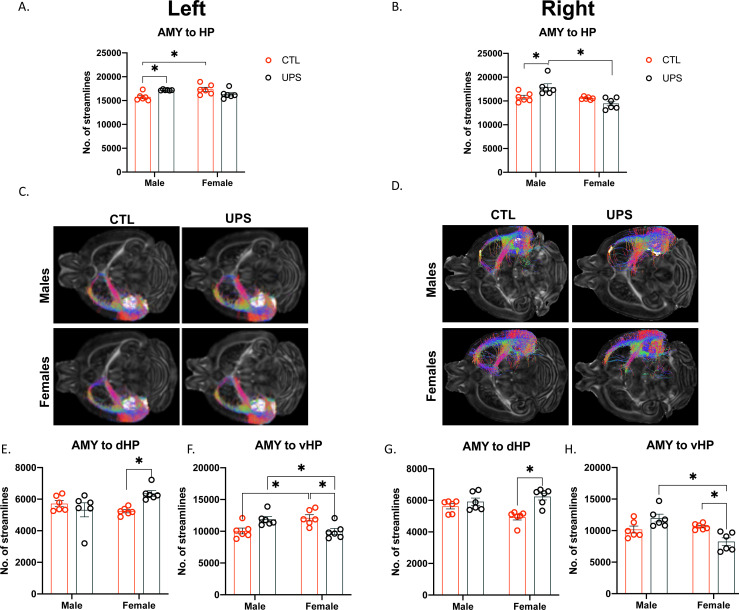
Amygdala (AMY)–hippocampus tractography for the left (A, C, E, and F) and the right hemispheres (B, D, G, and H).Number of streamline projections between the AMY and entire hippocampus is summarized in A and B and representative tracing shown in C and D. Summaries of the number of projections between the AMY and the dorsal hippocampus are shown in E and G with similar quantification for AMY–ventral hippocampus connectivity summarized in F and H. n = 6 per rearing condition and sex with graphs showing mean and SEM, *p<0.05.